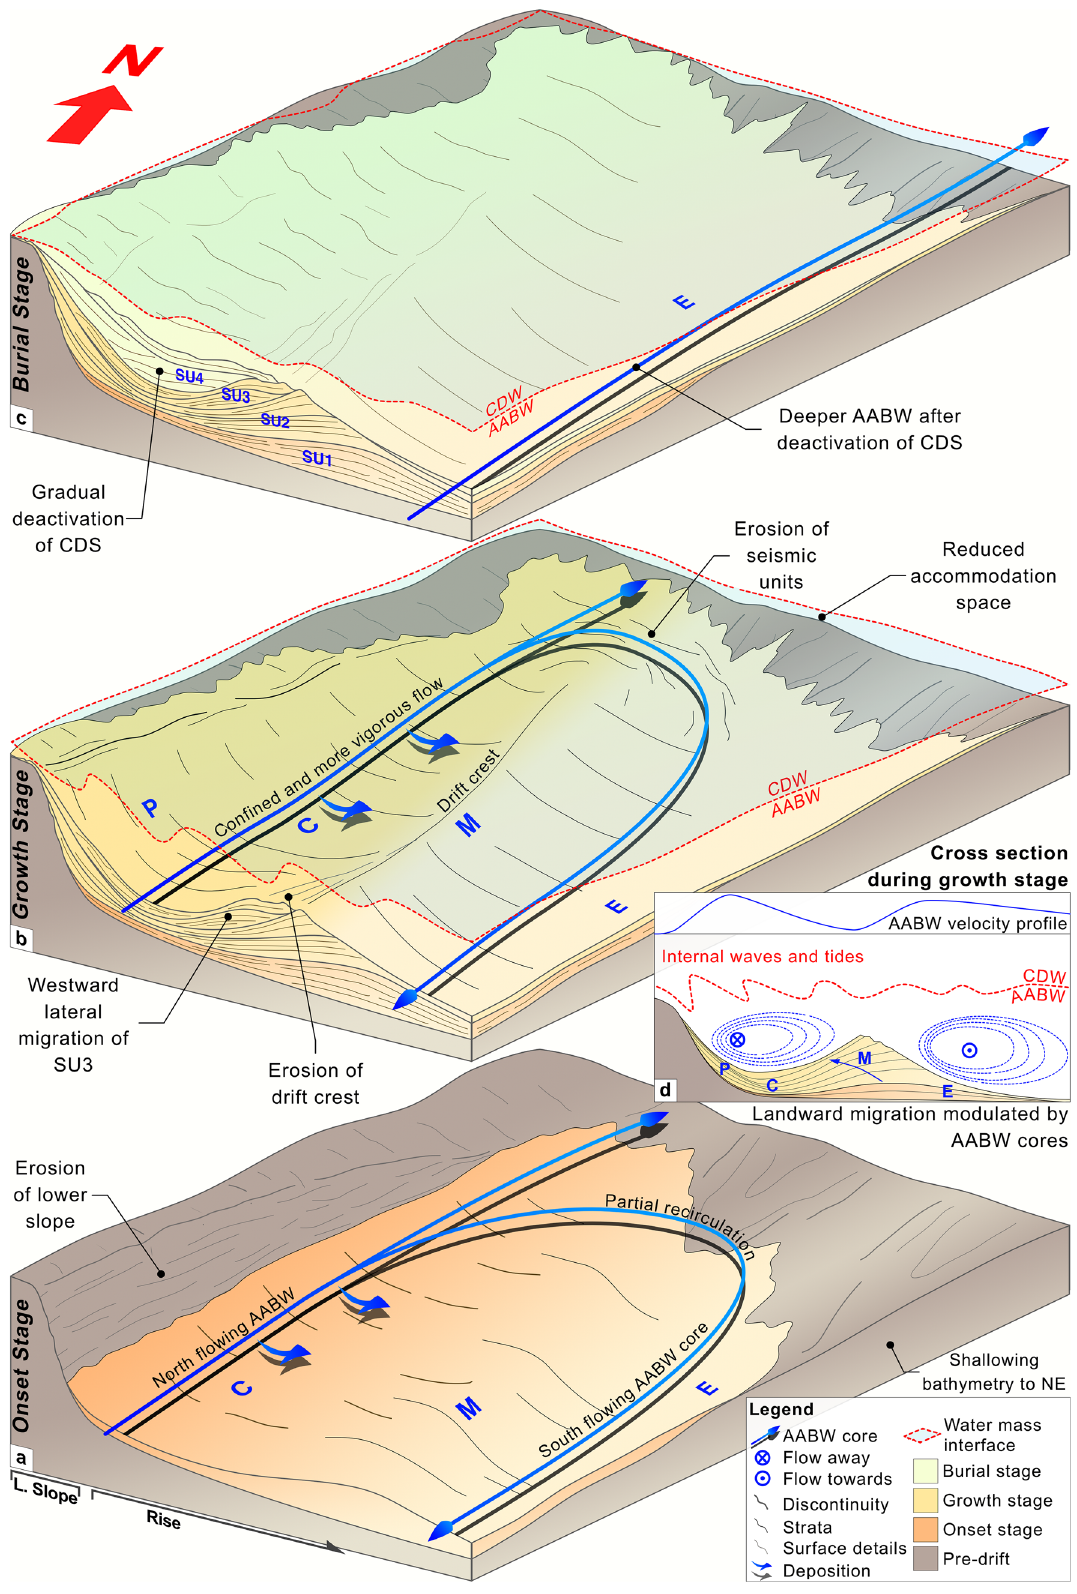
Figure 4. Conceptual models ( a – c ) depicting CDS evolutionary stages, AABW pathways, and AABW/CDW interface; cross-section diagram ( d ) of the upslope migration. The figure was generated using Pixelmator Pro 2.1.3 Coral (https:// www. pixel mator. com/